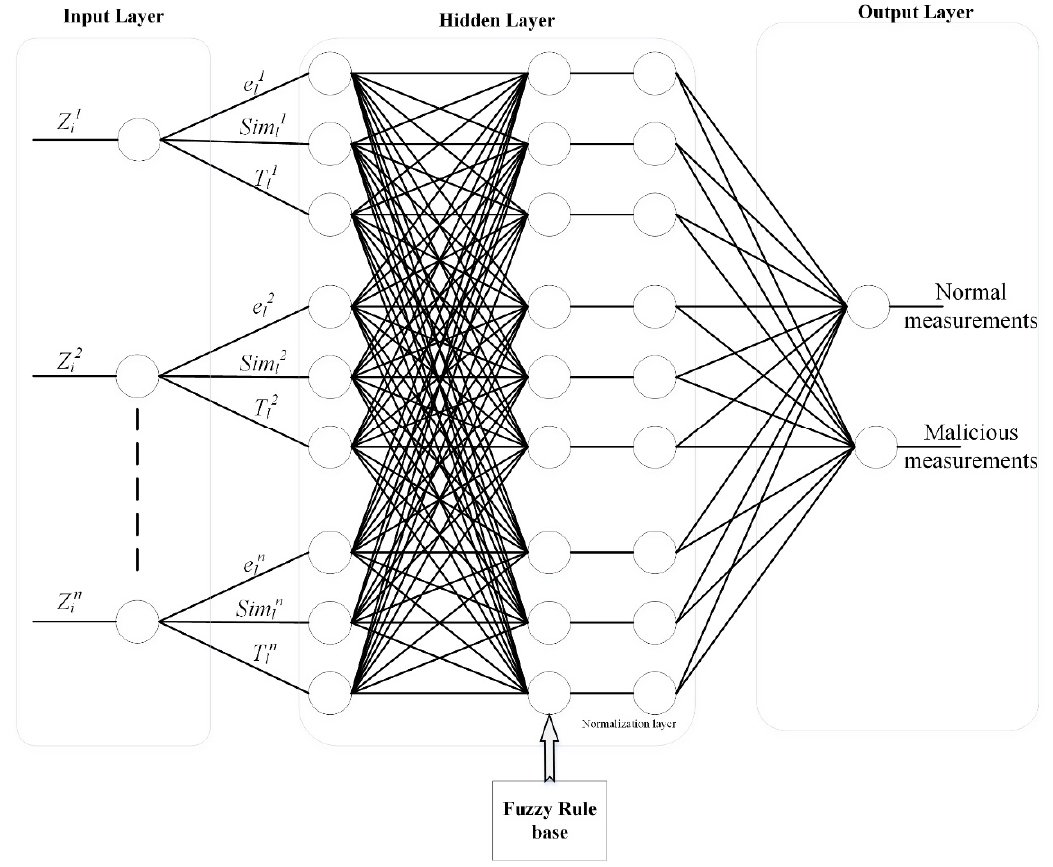
Figure 6. Fuzzy with neural network (FNN) algorithm based measurement